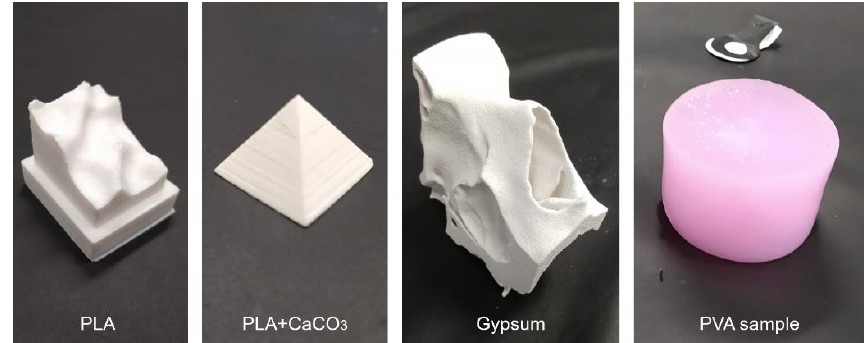
Figure 5. Pictures of the X-ray sample materials that have been tested.